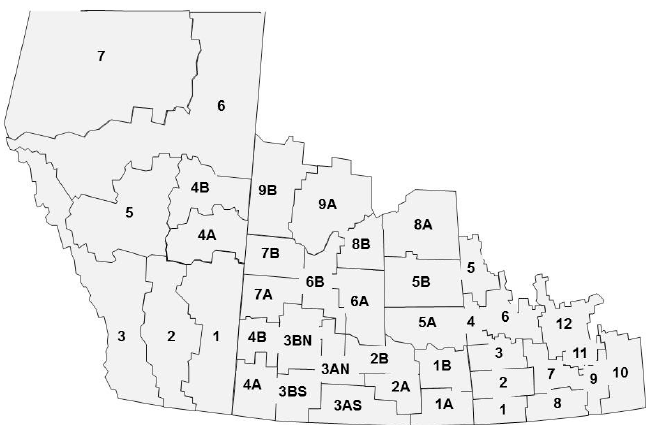
Figure 7. Scheme of the western provinces (Manitoba, Saskatchewan and Alberta) with the crop district divisions used in the Canadian Grain Commission harvest survey.